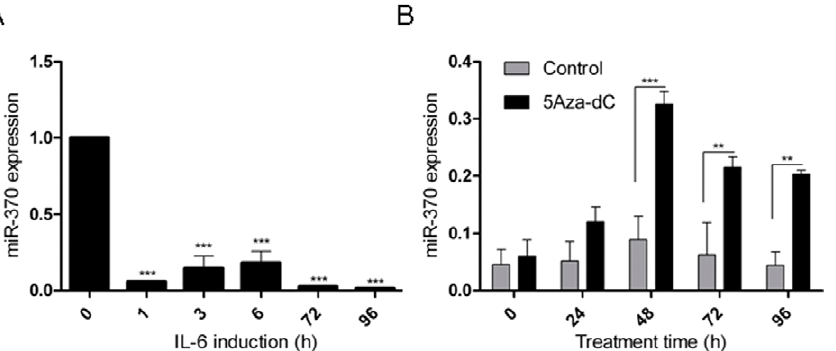
Figure 2. IL-6 and promoter methylation modulate expression of miR-370. A. IL-6 reduces miR-370 expression in HuCCT1 cells. X- axis – duration of IL-6 treatment (in hours). Y-axis – Mean and standard deviation of qRT-PCR-measured expression of miR-370 normalized to RNU6B. B. Treatment with the demethylating agent 5Aza-dC upregulates miR-370 expression in HuCCT1 cells. Black column - 5Aza-dC-treated cells, gray column – negative control. X-axis –the duration of 5 Aza-dC treatment (hours). Y-axis – Mean and standard deviation of qRT-PCR-measured expression of miR-370 normalized to RNU6B. Data represents the mean value of three independent experiments, **P , 0.01, ***P , 0.001.